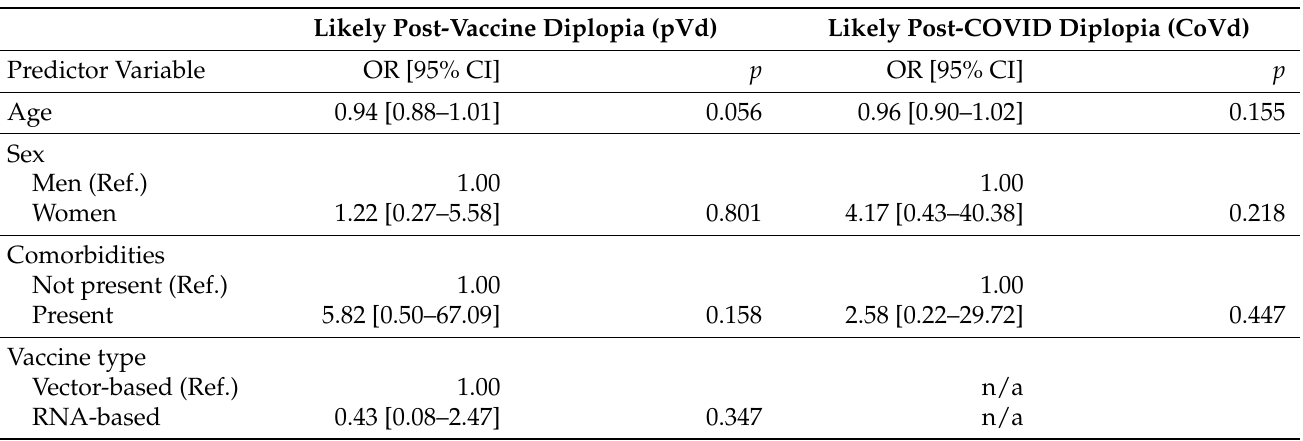
Table 3. A logistic regression model used to explore the differences between likely post-vaccination diplopia (pVd) and likely COVID-caused diplopia